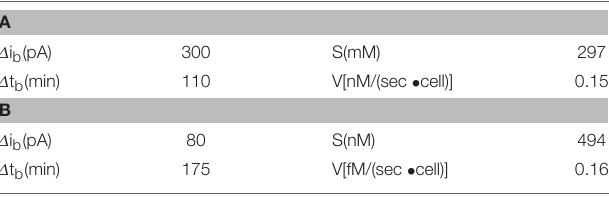
TABLE 1 | Oxygen consumption calculated using standard bulk oxygen of 209 µ M and H 2 O 2 generation during the respiratory burst calculated using calibration curve (equation y = 8.49 × 10 − 10 × ).